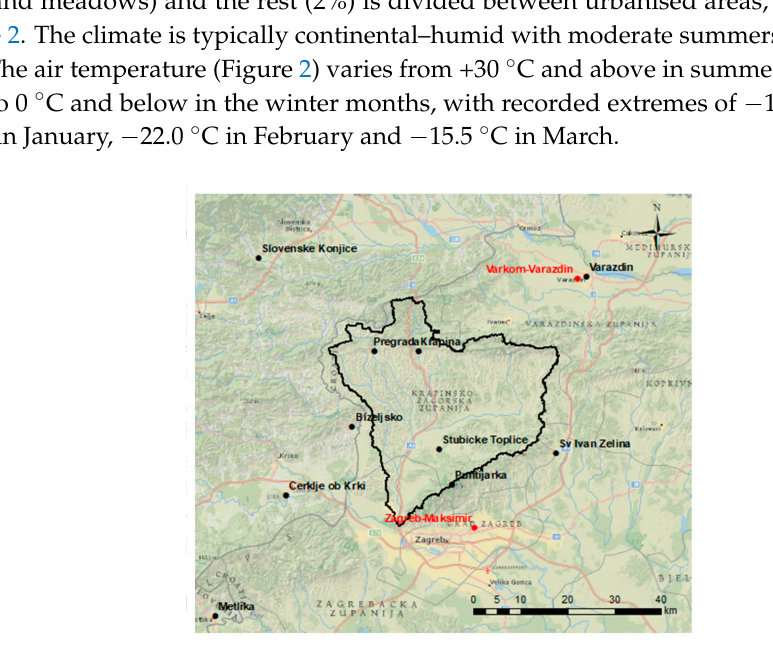
Figure 1. Layout of the Krapina River basin with locations of meteorological (black) and lysimeter (red) gauging